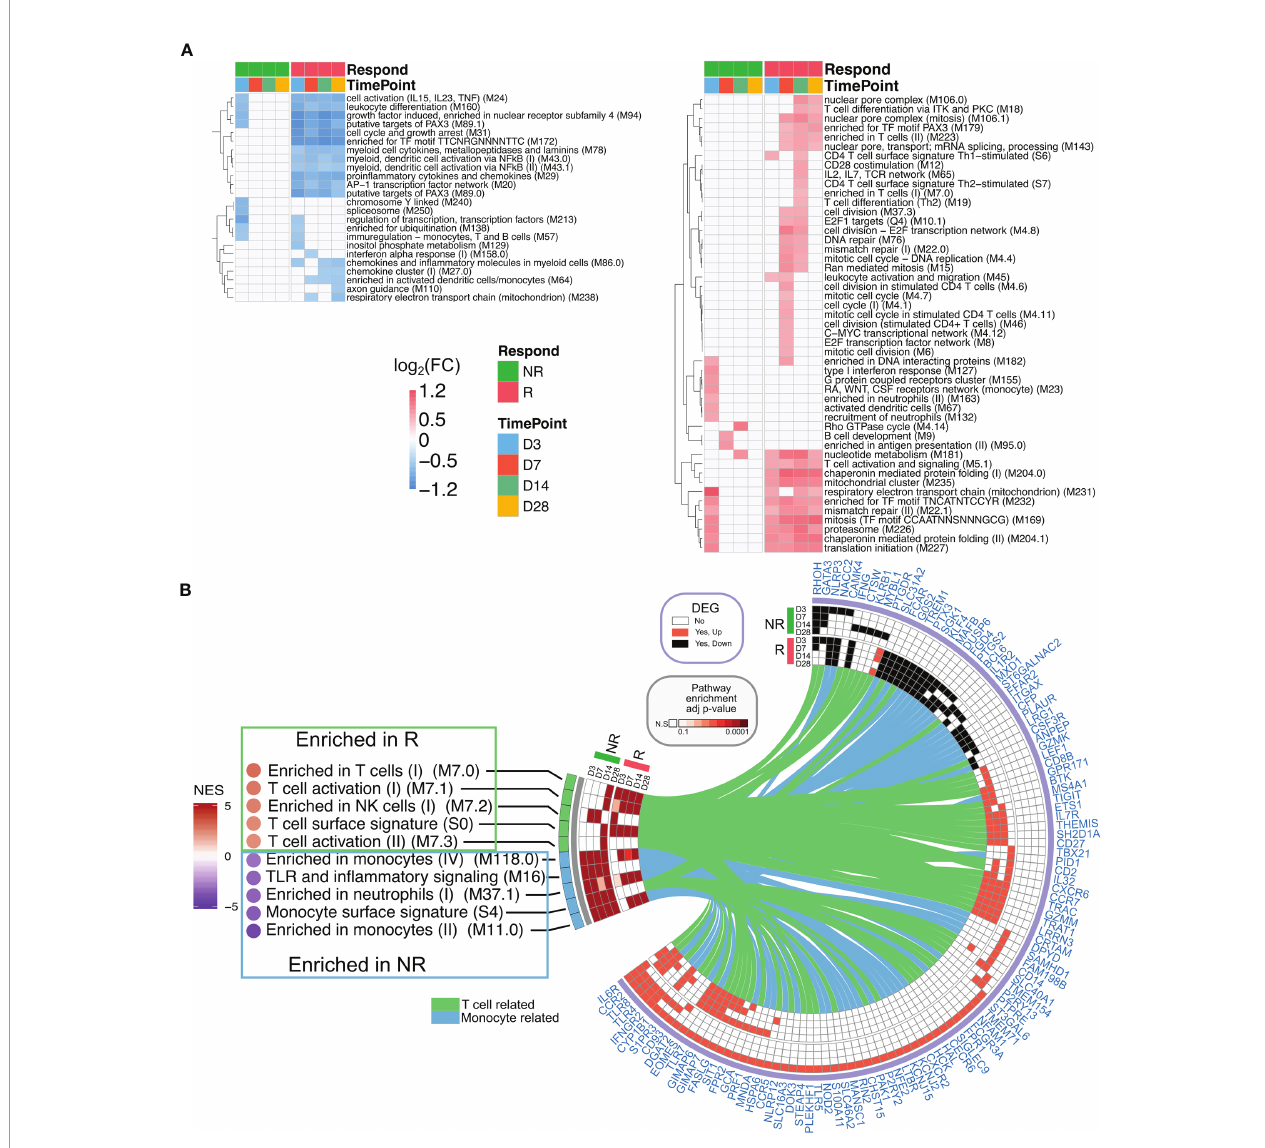
FIGURE 4 | Transcriptional pro fi ling of responders (Rs) and non-responders (NRs). (A) Heatmap showing blood transcriptional modules (BTMs) up/downregulated at least 1.2 fold change in the post-vaccination enrichment score compared to the baseline score and false discovery rate (FDR) < 0.05 after the recombinant Tiantan vaccinia-based HIV-1 vaccine (rTV/HIV-1) booster vaccination. Green ( left ), non-responders; red ( right ), responders. (B) Gene set enrichment analysis (GSEA) of the pre-ranked genes based on the neutralizing antibody (nAb) titers is shown in the left panel . NES , normalized enrichment score. Positive and negative enrichment denoted by red and blue , respectively. Circos plot represents the differentially expressed genes (DEGs) and the GSEA for the groups of NRs and Rs on day 3 through day 28. The BTM enrichment adjusted p -values are presented on the left arc , and the log 2 fold change values compared to the baseline of DEGs belonging to each BTM are shown on the right arc . DEGs are connected to their corresponding BTM(s) with lines